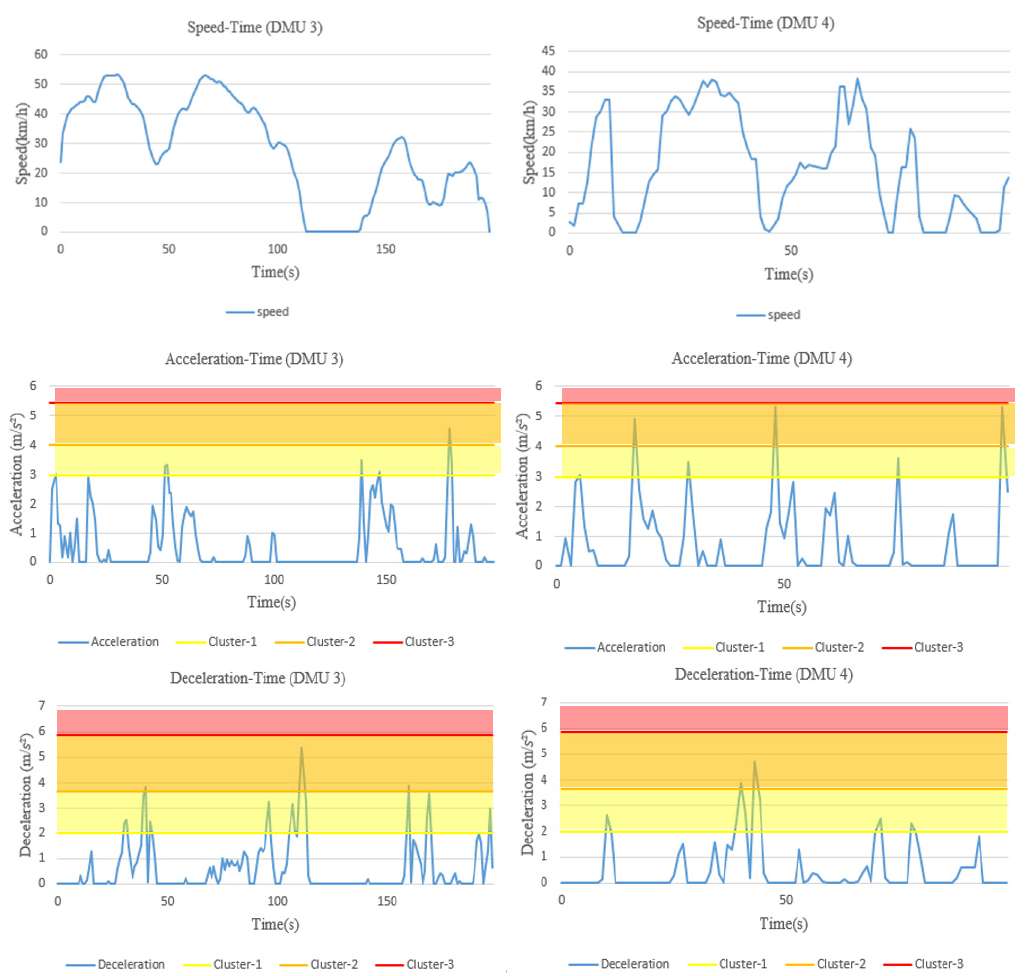
Figure 7. The driving behavior data of DMUs 3 and 4.